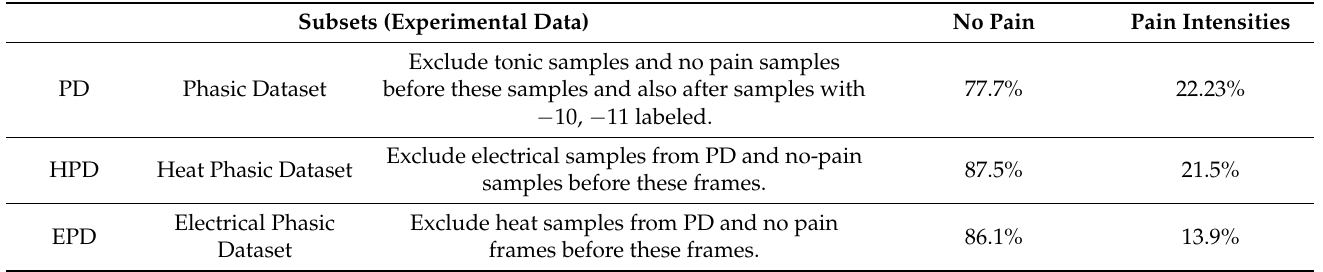
Table 2. List of datasets with samples’ distribution based on labels. Subsets (Experimental